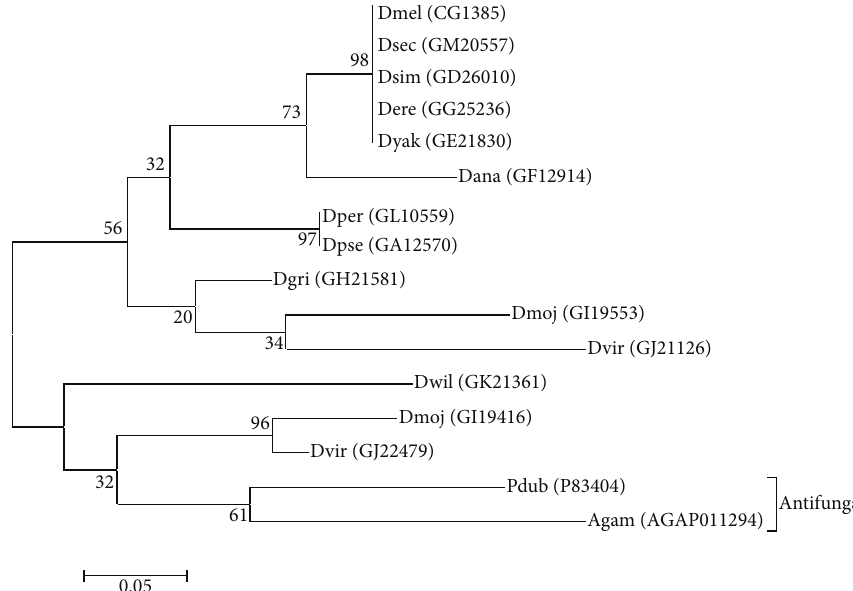
Figure 5: Neighbor-joining phylogenetic tree of Drosophila Defensin genes with antifungal Defensin genes of sand fly ( Phlebotomus duboscqi ) and mosquito ( Anopheles gambiae ). Amino acid sequences of the mature peptide were aligned by CLUSTAL W [12] and the phylogenetic tree was reconstructed with the Poisson model by MEGA5 [13]. For each Defensin gene, abbreviated four-letter species code (Dmel: Drosophila melanogaster , Dsec: D. sechellia , Dsim: D. simulans , Dere: D. erecta , Dyak: D. yakuba , Dana: D. ananassae , Dper: D. persimilis , Dpse: D. pseudoobscura , Dgri: D. grimshawi , Dmoj: D. mojavensis , Dvir: D. virilis , Dwil: D. willistoni , Pdub: Phlebotomus duboscqi and Agam: Anopheles gambiae ) with Gene ID or Uniprot ID in parenthesis is shown as an operational taxonomic unit. The Defensins genes of D. melanogaster and D. virilis were indicated by bold face. The number along each branch is the bootstrap value computed by 1,000 bootstrap